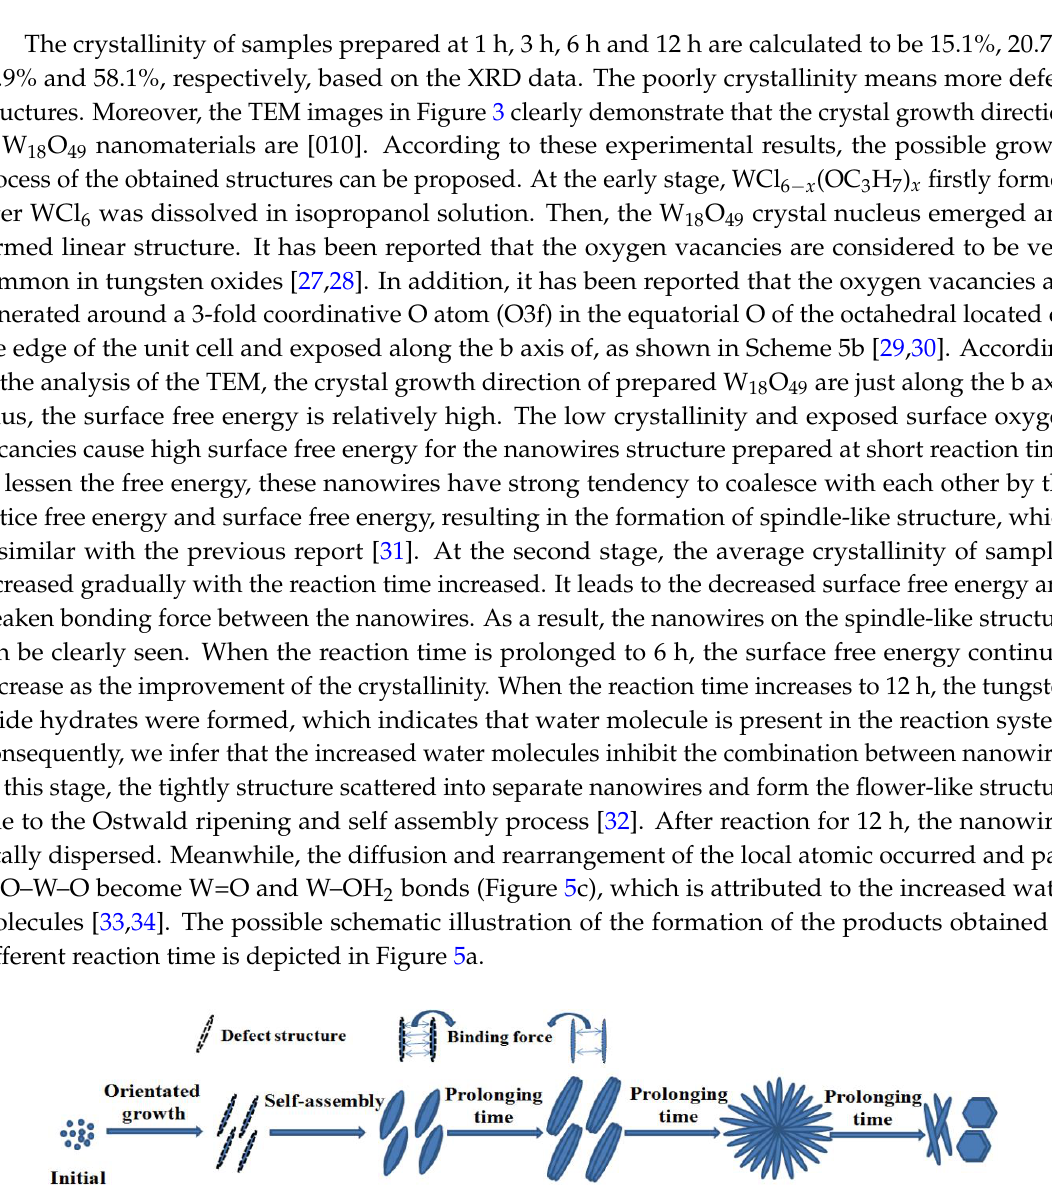
(1 h) < W 18 O 49 (3 h) < W 18 O 49 (6 h) < WO 3 ∙0.33H 2 O/W 18 O 49 (12 h). In the region of 500–800 nm, the